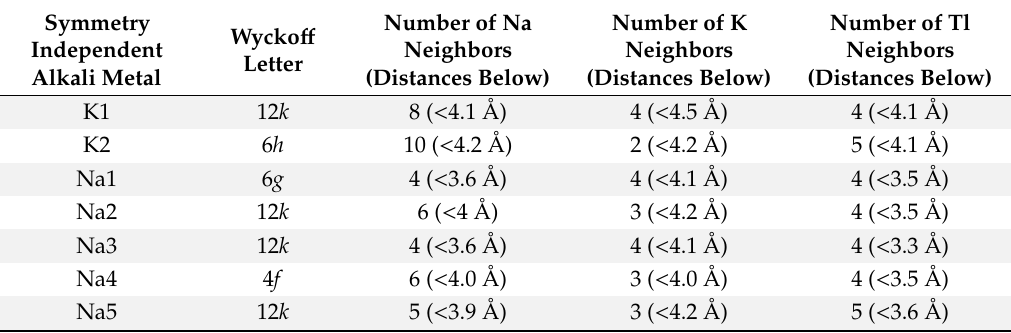
Figure 14. Atomic environment of the symmetry inequivalent alkali metals in Na 23 K 9 Tl 15.3 . The corresponding range of distances to the adjacent atoms as well as the Wyckoff letters are given in Table 16. Table 16. Surrounding atoms of the symmetry inequivalent alkali metal positions in Na 23 K 9 Tl 15.3 (space group P 6 3 / mmc ).